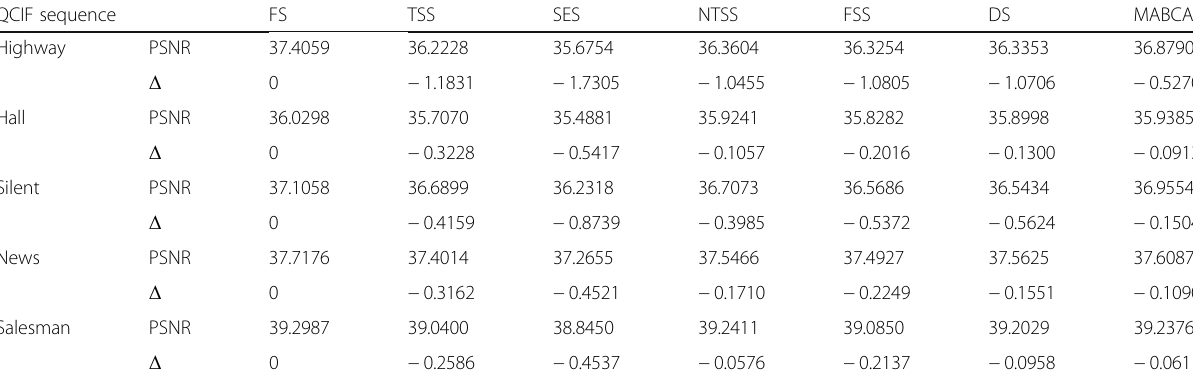
Table 5 The average PSNR values of the five QCIF sequences using the seven methods QCIF sequence FS